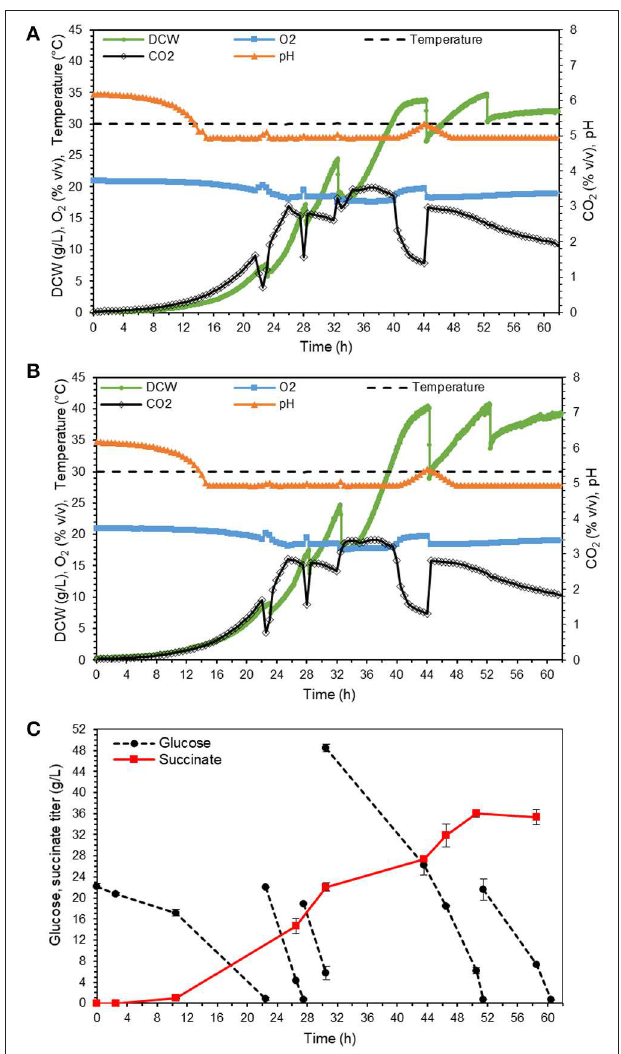
FIGURE 7 | Bioreactor fermentation results of adapted strain in minimal medium in two 1L fermenters, with online data for individual reactors (A,B) , and offline measurements as average for both reactors (C) , error bars indicate standard deviation calculated from the two independent bioreactor